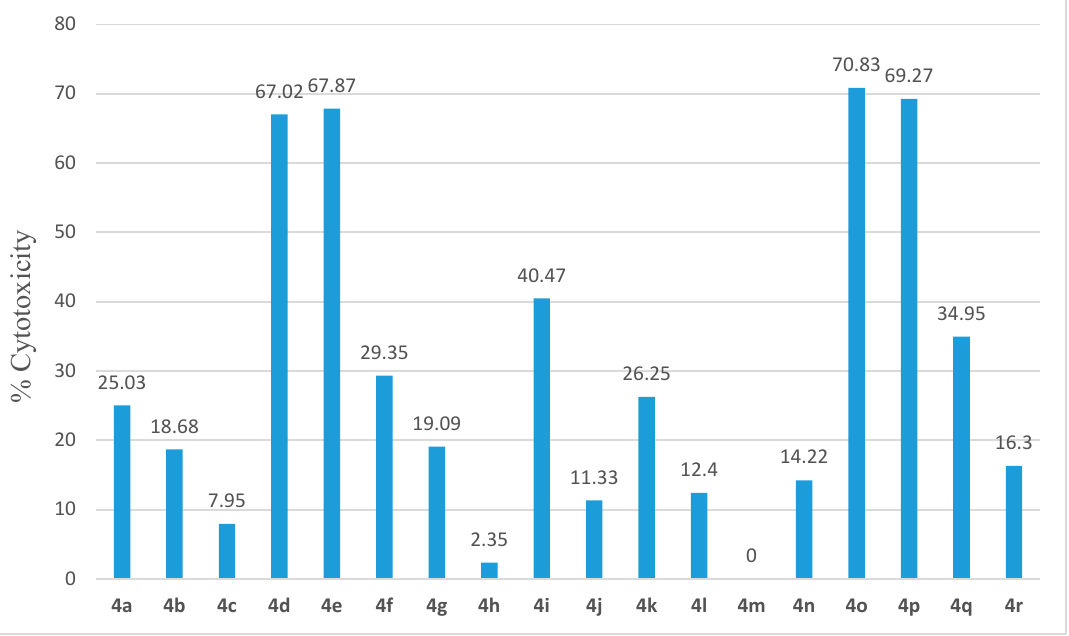
Figure 4. Mean % inhibition of NCI-60 cell lines after treatment with a single dose (10 µM) of compounds 4a ‒ r .